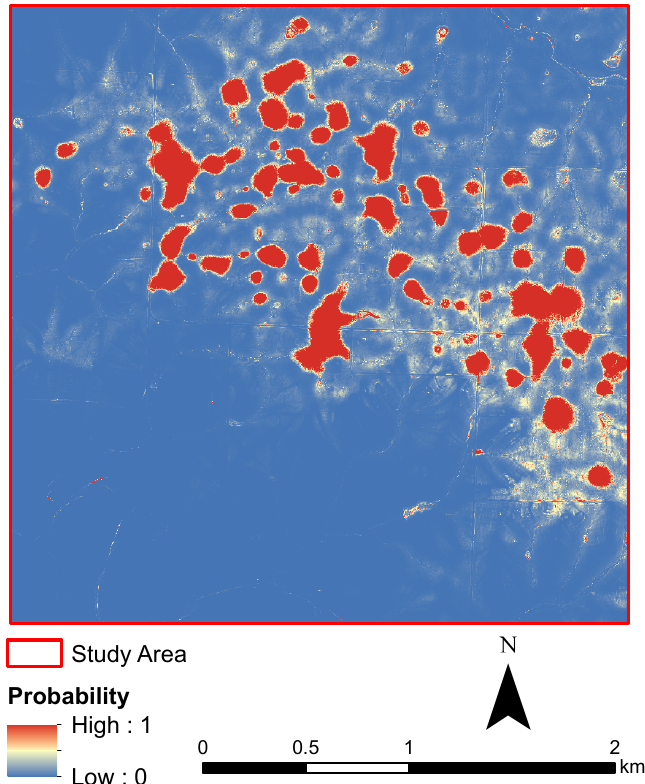
Figure 5. Probabilistic sinkhole susceptibility map of the study area using LR method.